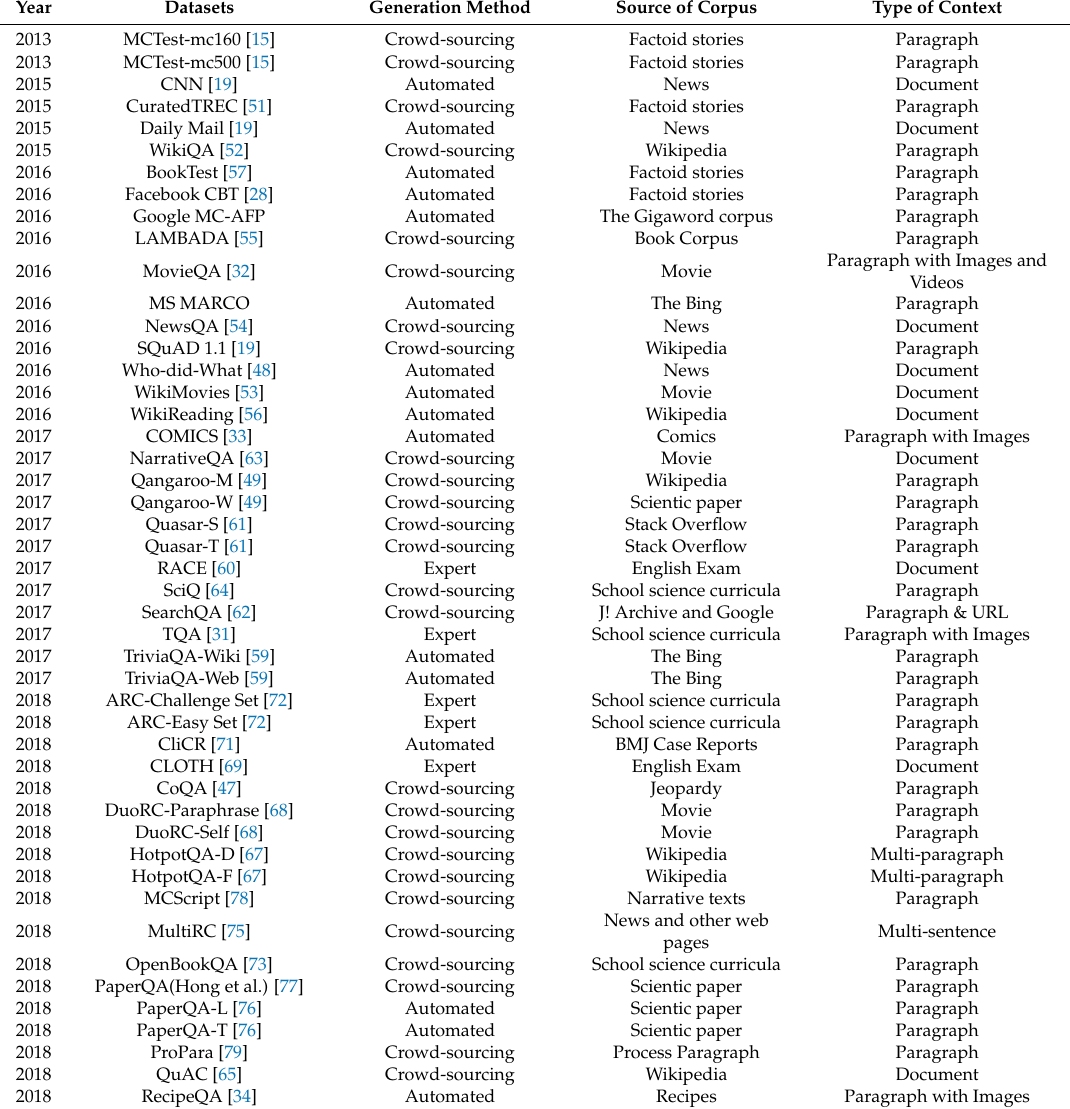
Table 6. The generation method of datasets, source of corpus and type of